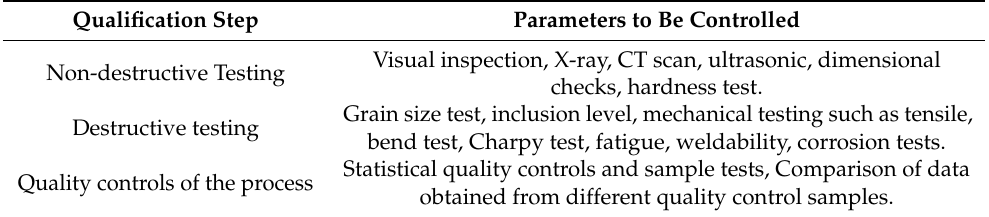
Table 4. The Main concerns in the qualification of final